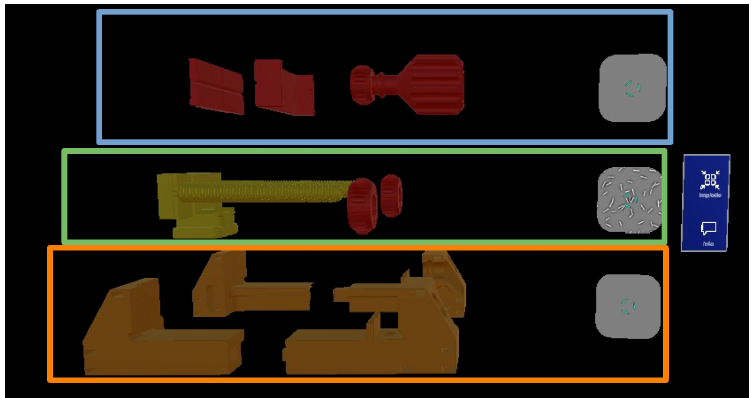
Figure 5. The exploded vise is divided into three